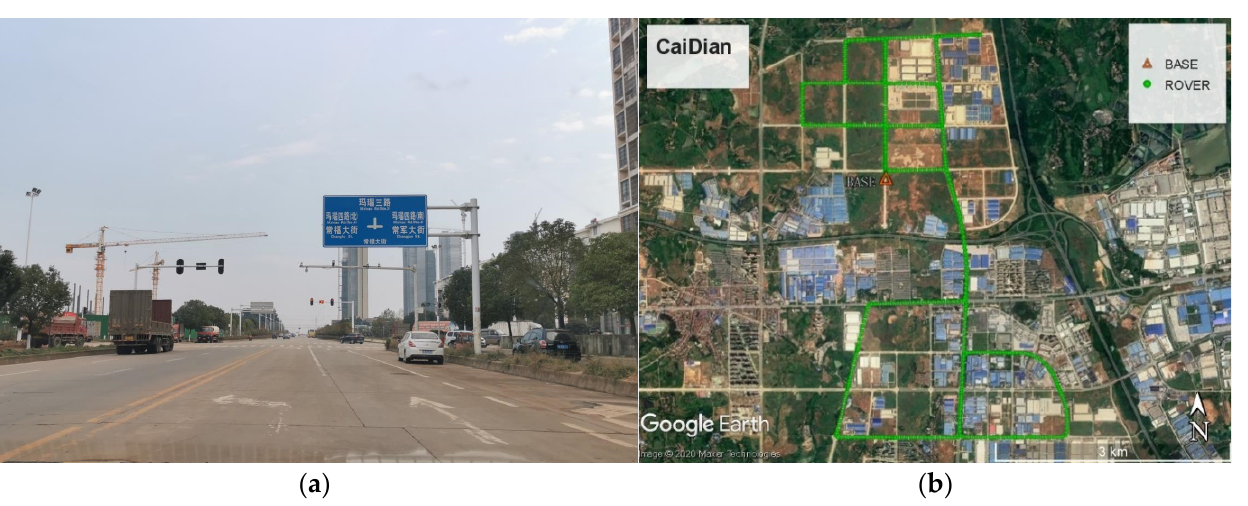
Figure 12. Kinematic vehicle experiment in the open urban environment: ( a ) test scene; ( b ) test tra- jectory.